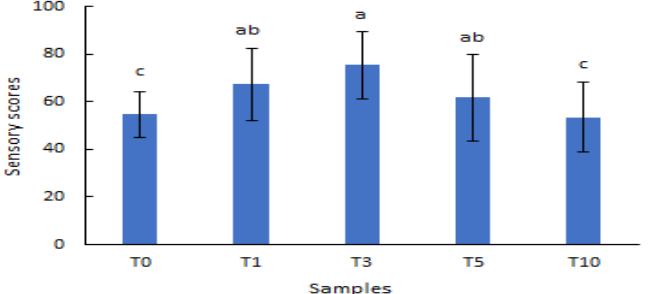
Figure 6. Sensory evaluation of beer samples fermented with D. officinale . T0, T1, T3, T5, and T10 were the samples with 0, 10, 30, 50, and 100 g/L of D. officinale , respectively. Different letters indicate significant differences at p < 0.05.